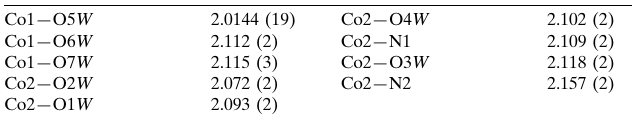
Selected bond lengths (A˚ ).